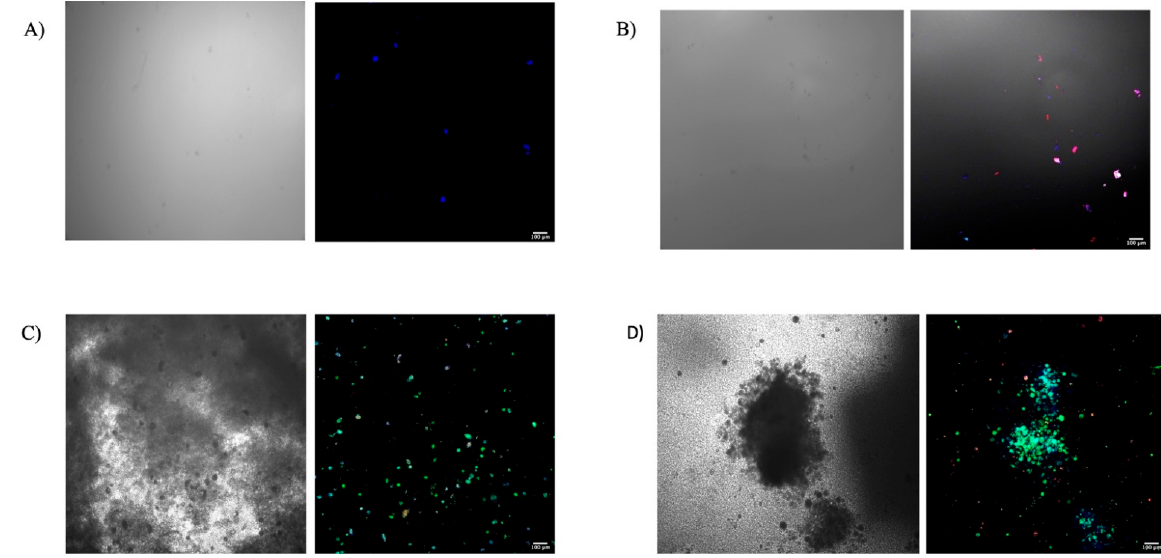
Figure 4. Representative DAPI (Blue)/Anti-Osteocalcin antibody (Green)/Anti-Osterix antibody (Red) immunostained cells in hydrogel samples for differentiation assay, showing the expression of Osteocalcin positive cells among the groups on the right side and the corresponding bright field images on the left side. ( A ) Control with CEM, ( B ) Control group with OM, ( C ) PDGF-BB group, ( D ) PRP lysate group.